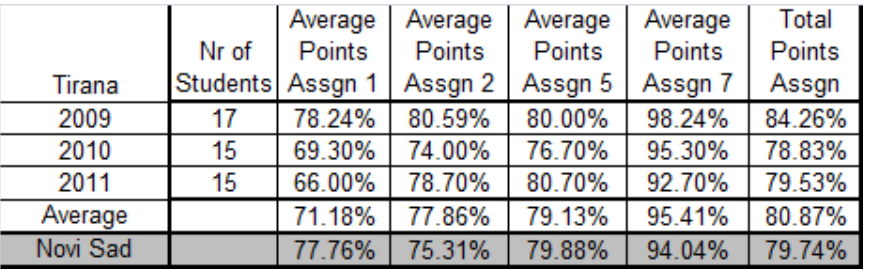
Assignment Points for Tirana Master Students